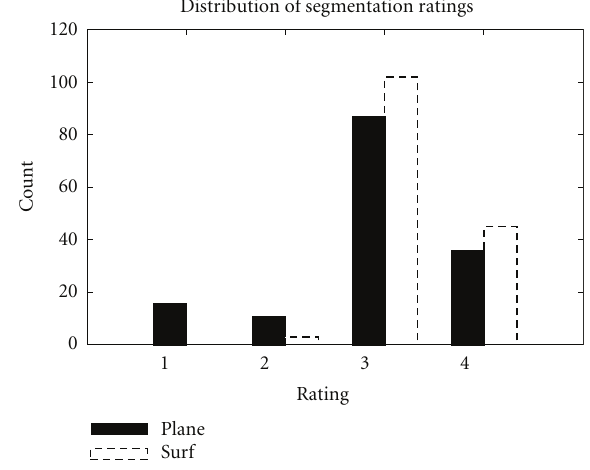
Figure 14: Distribution of ratings for segmentations by the surface- fitting and plane-cutting